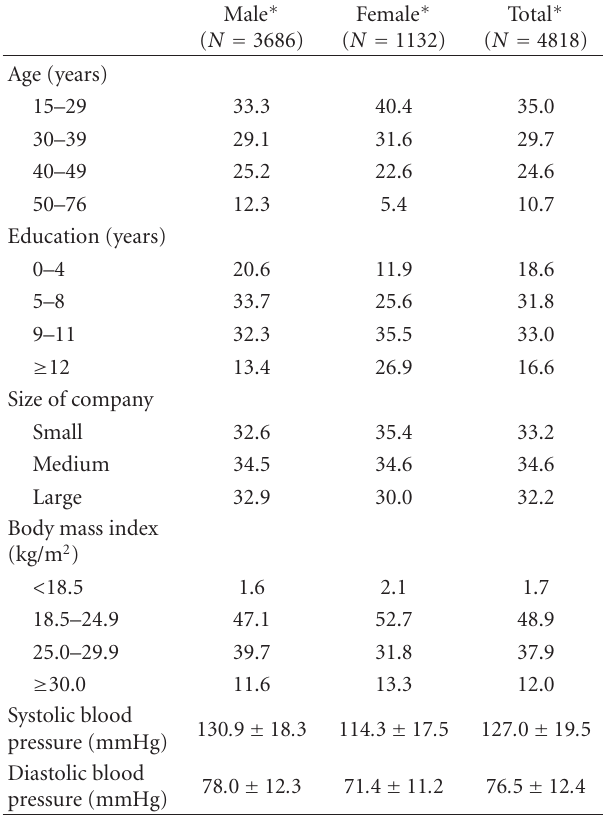
Table 1: Characteristics of the Brazilian workers of the SESI study ((%) or mean ± standard